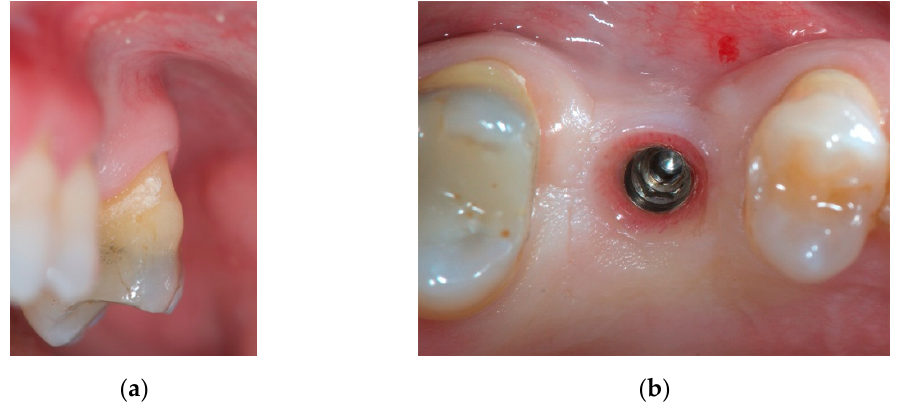
Figure 2. Intraoral view of the soft tissues before the peri-implant plastic surgery procedure: ( a ) Buccal view. ( b ) Occlusal view.